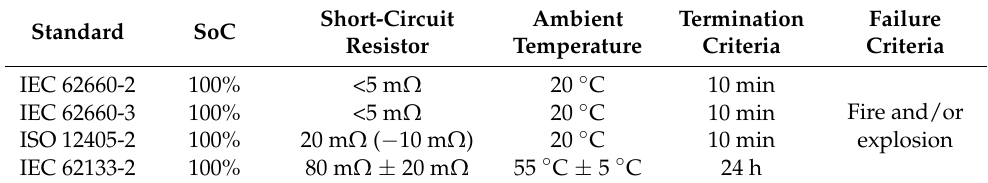
Table 3. Comparison of the parameters for a short-circuit test [9 – 12 . ]